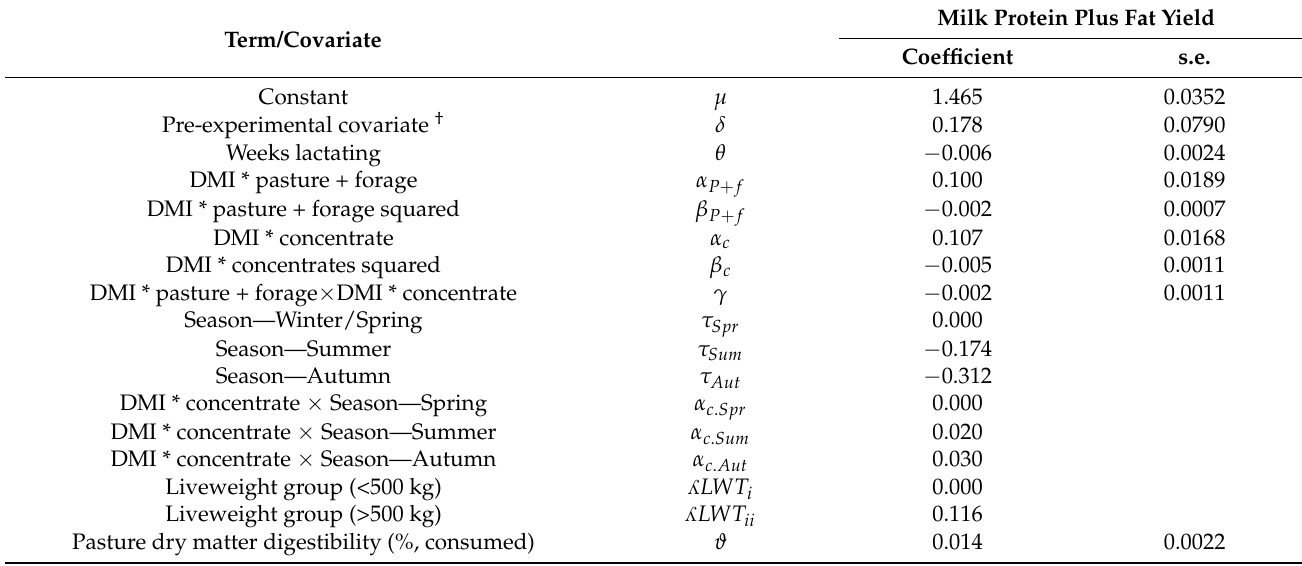
Table 5. Coefficients and standard errors (s.e.) for covariates included in the model for milk protein plus fat yield (kg/cow ·